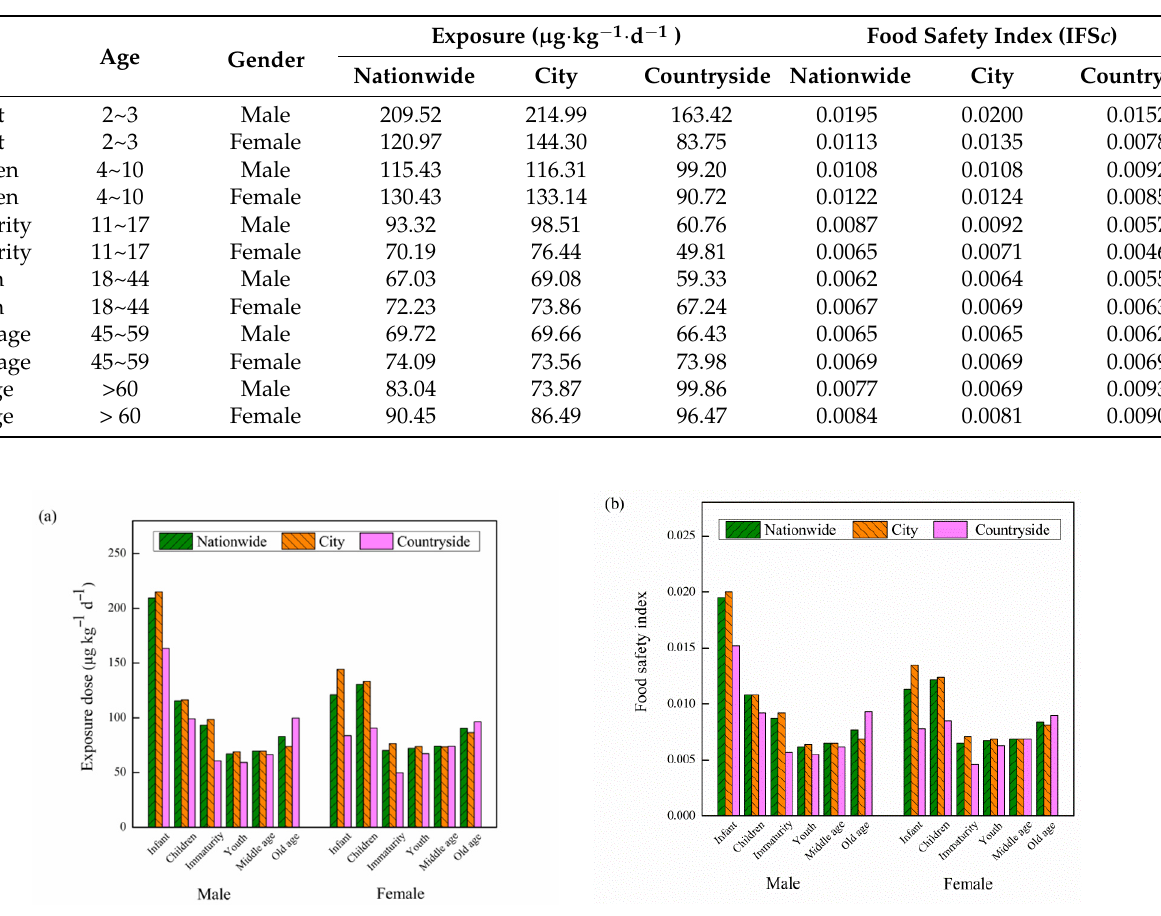
Figure 7. Dietary exposure ( a ) and food safety index ( b ) of total biogenic amines in different regions, sexes and age stages.